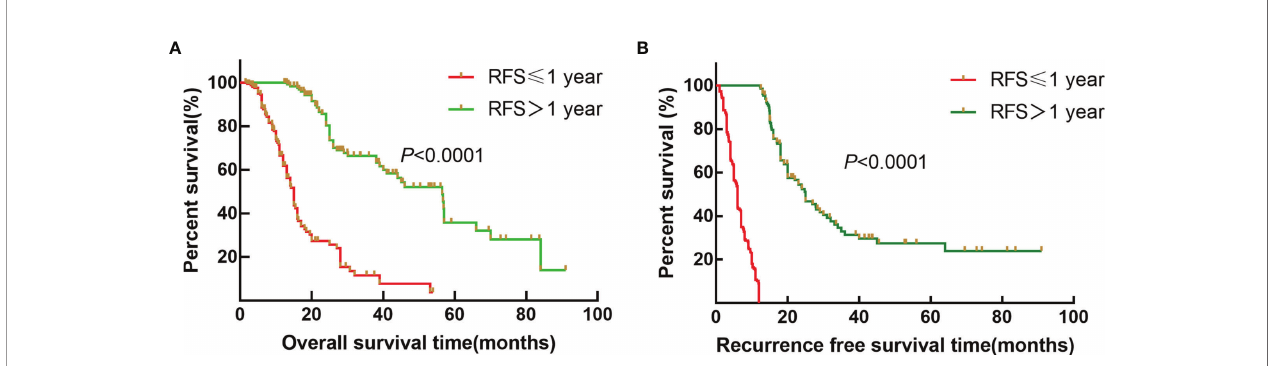
FIGURE 1 | Survival curves of patients with ICC after radical resection between the early recurrence group and late recurrence group. (A) Kaplan – Meier OS curve for ICC patients between the early recurrence group and late recurrence group. (B) Kaplan – Meier RFS curve for ICC patients between the early recurrence group and late recurrence